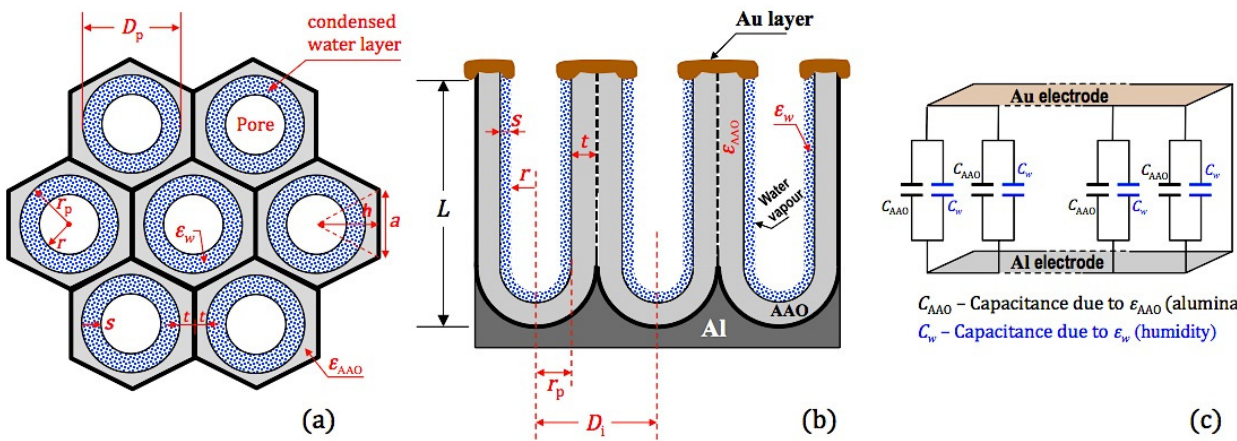
Figure 8. Schematic representation of a nanoporous alumina humidity sensor: ( a ) top view of the NP-AAO array under hexagonal projection geometry; ( b ) cross-sectional (side) view of the NP-AAO based humidity sensor considering individual dielectric constant of alumina and that of the water vapour; ( c ) equivalent circuit of the NP-AAO capacitive-type humidity sensor device. Table 5. Capacitance values of NP-AAO samples estimated by the qualitative model (from Equation (8)). Sample